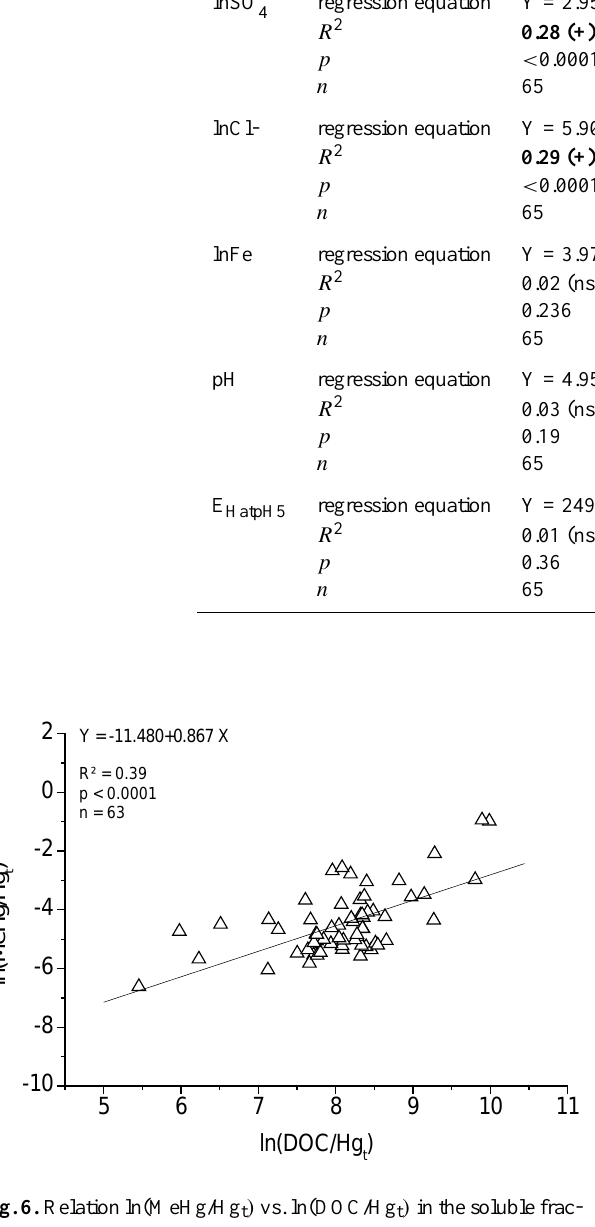
Fig. 6. Relation ln(MeHg/Hg t ) vs. ln(DOC/Hg t ) in the soluble frac-